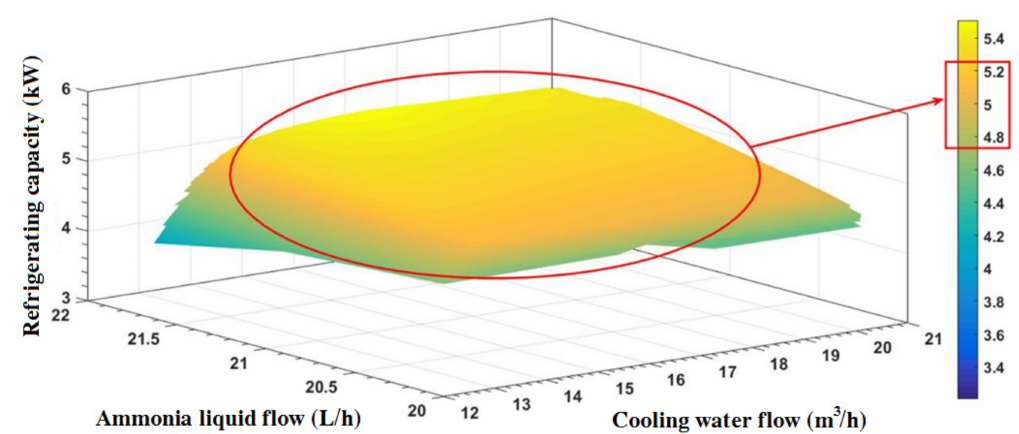
Figure 15. Refrigerating capacity output based on predicted